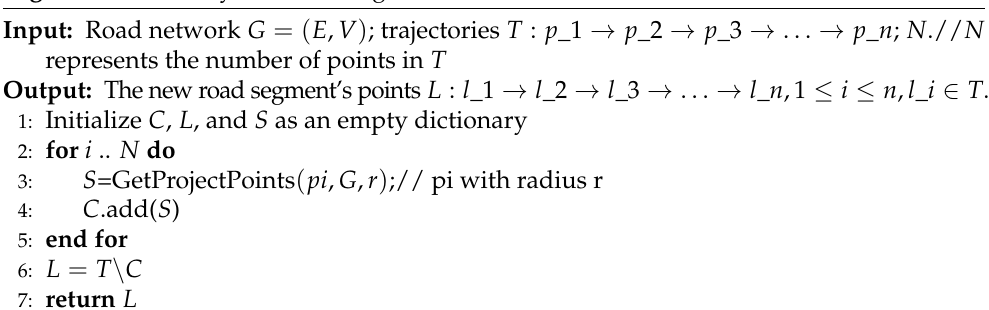
Algorithm 1 Identify new road